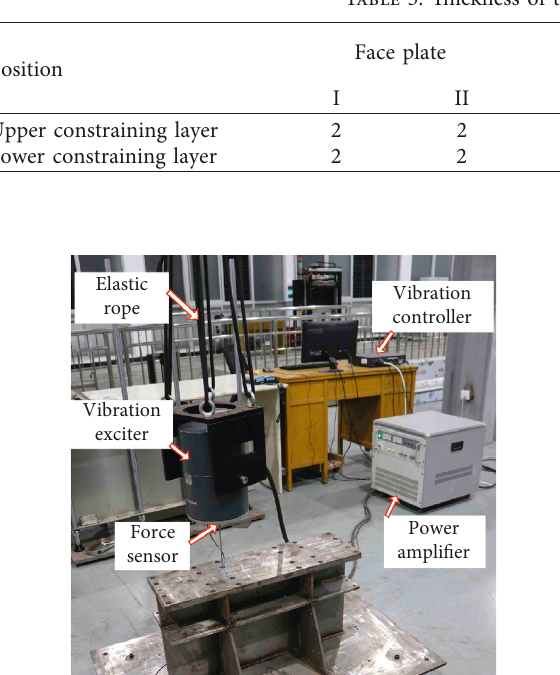
Figure 14: Displacement deviation between foundation and restraint layers in the position of the connection plate. (a) Position I, upper constraining layer. (b) Position I, lower constraining layer. (c) Position II, upper constraining layer. (d) Position II, lower constraining layer. Table 5: Thickness of the constraining layer (unit: mm).